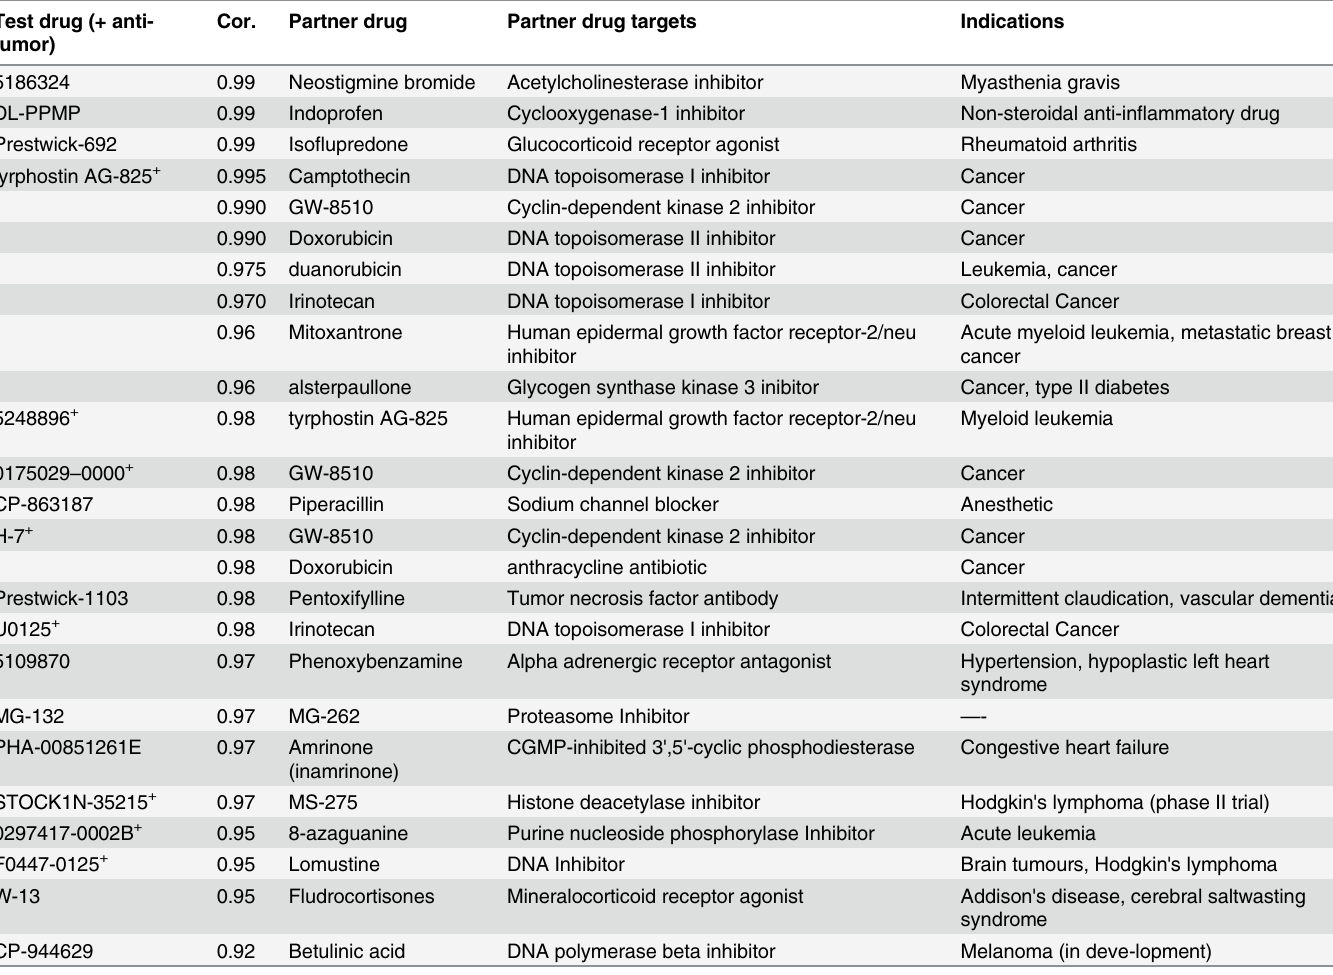
Table 2. Putative molecular target and pharmacology obtained from application of GSLHC on CMap perturbagens without known indication. Test drug (+ anti- Cor. tumor)